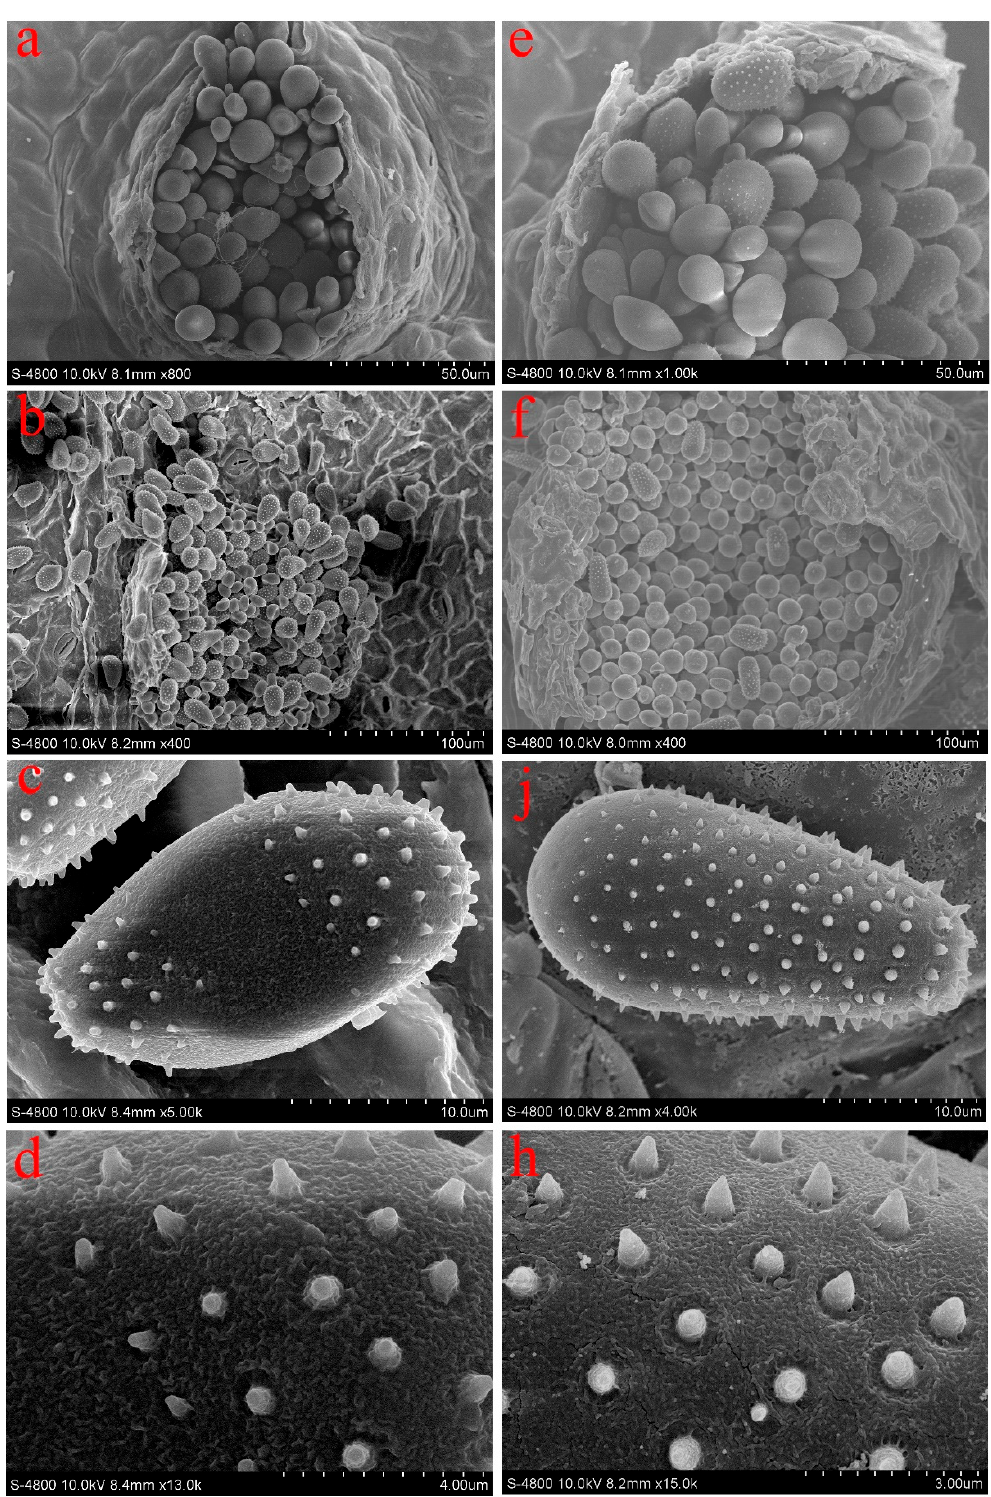
Figure 2. Echinulation patterns of urediniospores and associated paraphyses of Melampsora medusae and Melampsora larici-populina (the two species of Melampsora found on sections Tacamahaca and Aigeiros in our surveys in China) as observed in the SEM. ( a – d ) Melampsora medusae ; ( e – h ) Melampsora larici-populina ; ( a, e ) abundant paraphyses under SEM; ( b, f ) Uredinium under SEM; ( c, j ) urediniospores with echinulate spines under SEM; ( d, h ) spines on the surface of urediniospores under SEM.